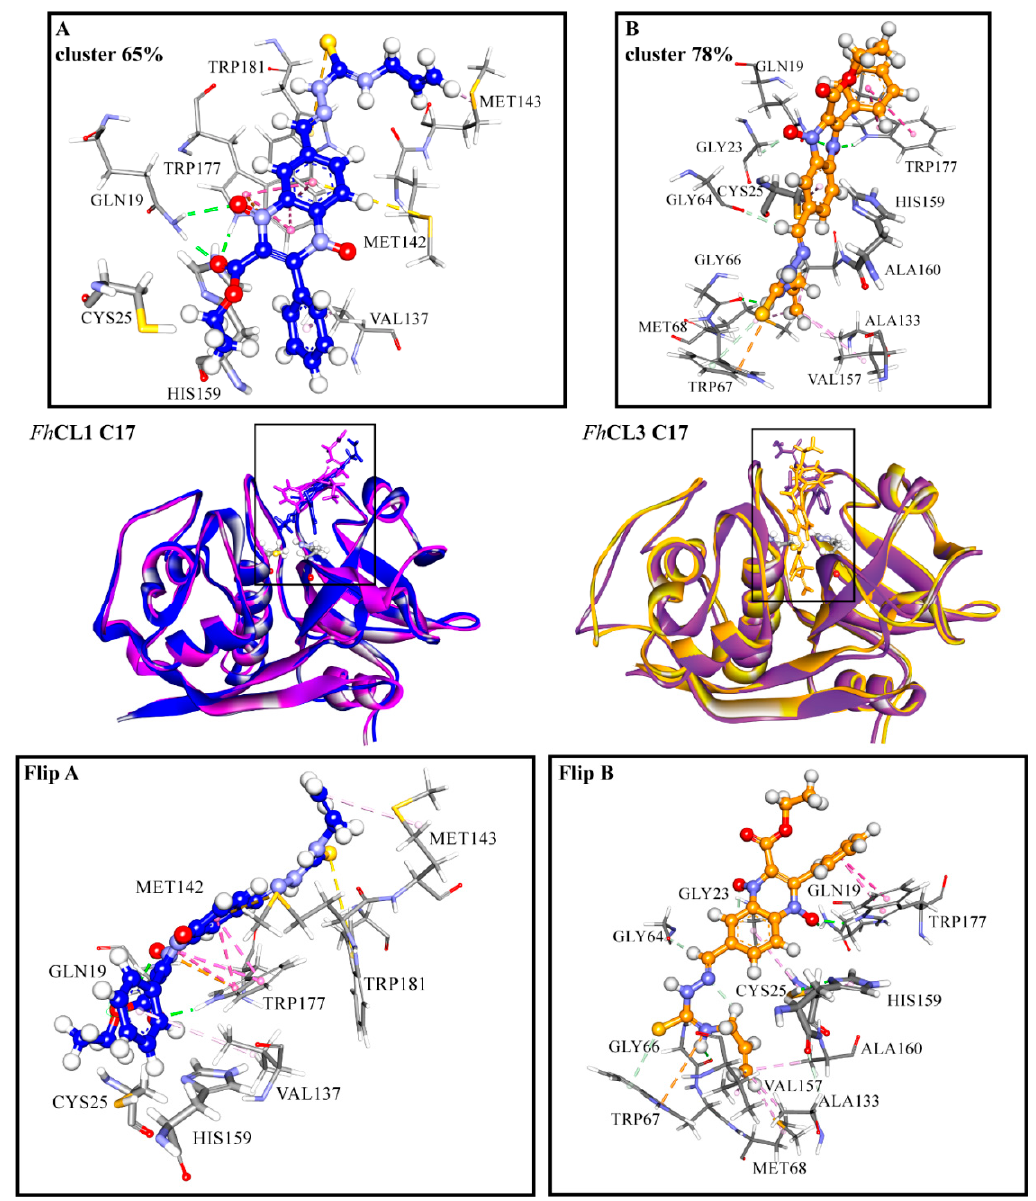
Figure 7. ( A ) Fh CL1 and ( B ) Fh CL3 interactions with C17 from MD simulations. In the middle is shown the most representative cluster structure obtained in the MD simulations for each enzyme-ligand complex in blue for Fh CL1 and orange for Fh CL3, and the most representative cluster obtained by the docking of both enzymes in purple. We zoomed in the region of the enzyme-ligand interaction for the most representative cluster to show the enzyme (sticks) and ligand (scaled ball and sticks) residues involved and the interaction types in dashed lines (green: hydrogen bonds, pink: hydrophobic interactions, yellow: pi-sulfur, orange: pi-cation). In the lower panels the complex with C17 for Fh CL1(Flip A) and Fh CL3 (Flip B) is seen from another perspective. The percentages correspond to the frequency obtained by the clustering of all the frames in each of the MD simulations. Residues are numbered according to papain (PDB code: